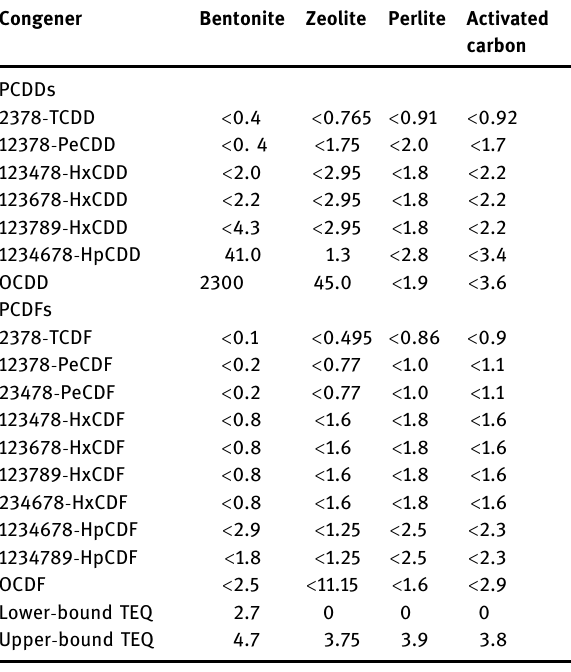
Table 4: Concentration of PCBs in sorbents ( pg/g DW )